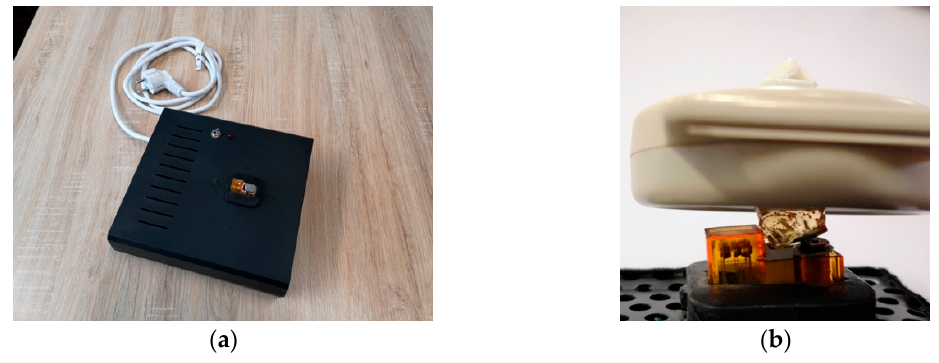
Figure 11. Final prototype of the fetal heart rate simulator device: ( a ) fetal heart rate simulator device. and ( b ) relay and US probe during simulation tests.